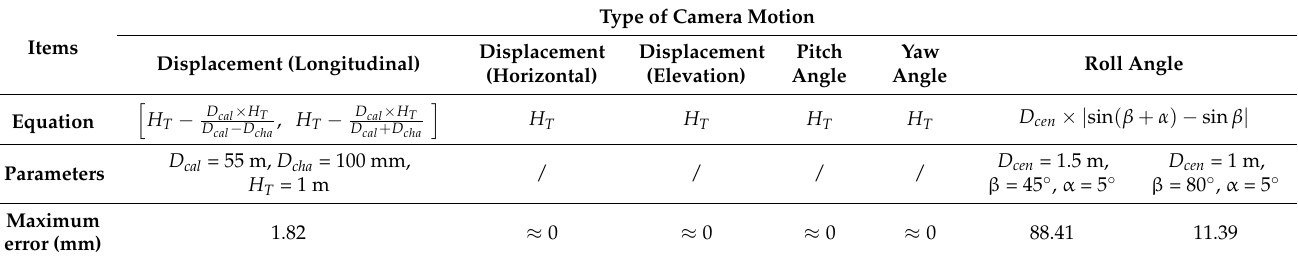
Table 3. Summary of measurement errors caused by wind-induced camera shaking.